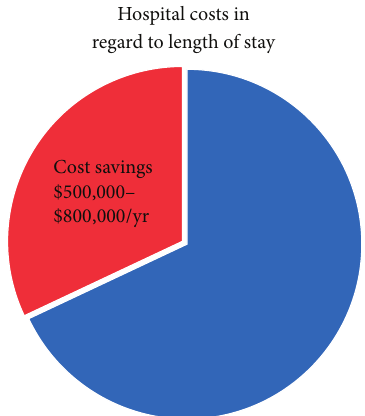
Figure 4: Potential cost savings per year for reduced length of stay in a 10-patient